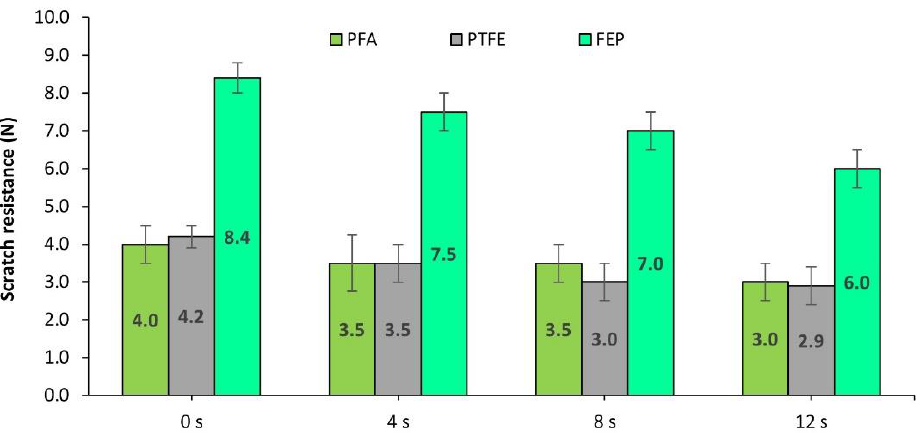
Figure 9. Evolution of the scratch resistance (N) shown by PFA-, PTFE-, and FEP-based fluoropolymeric coatings after 0, 4, 8, and 12 s wear processes via the projection of glass microspheres at 0.4 MPa.